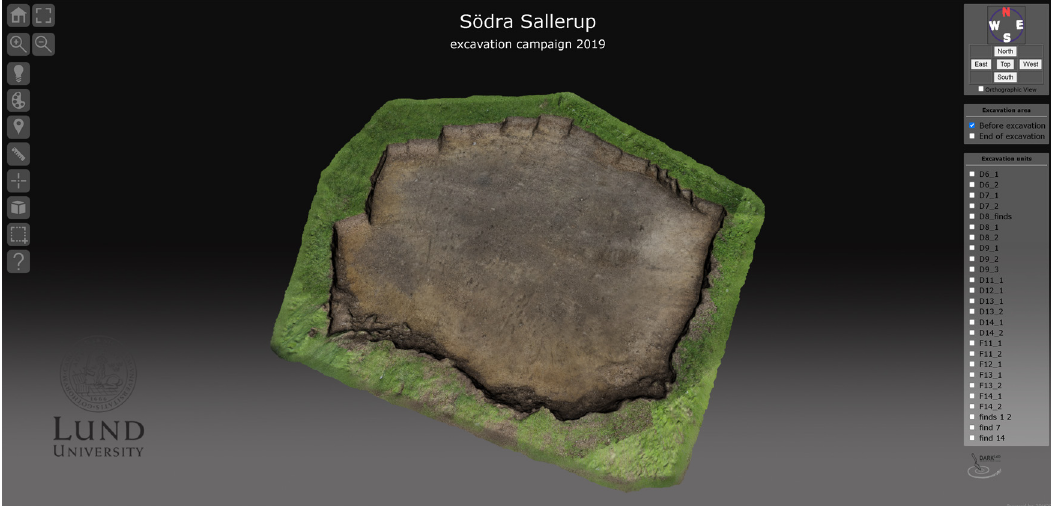
Figure 11: The interactive visualisation system of Södra Sallerup, in the centre: the canvas displaying the model; on the left: the visual and analytical tools; on the right: the available 3D models. Illustration: Paola